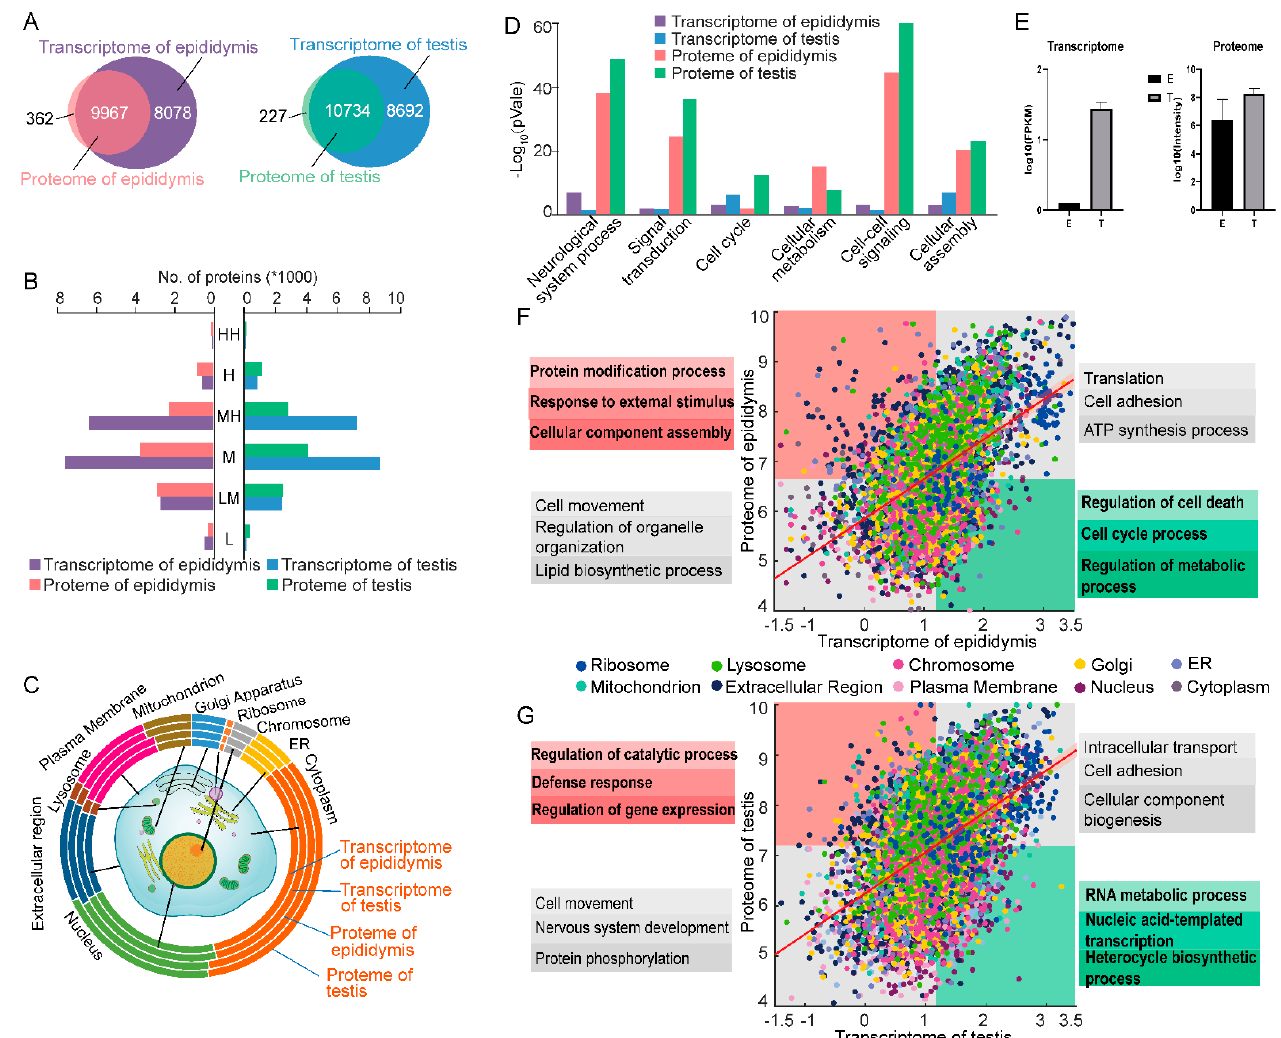
Figure 4. Integration of transcript and proteomic analysis. ( A ) Venn diagram of proteome and transcriptome; ( B ) Distribution of gene expression at the different levels; ( C ) Cellular component analysis of proteome and transcriptome; ( D ) GO annotation of the aggregation of transcription and proteomics of both tissues; ( E ) Analysis of ACE2 expression in testis and epididymis transcriptome and proteome profile; ( F , G ) Analysis of the correlation between proteomics and transcriptional data.